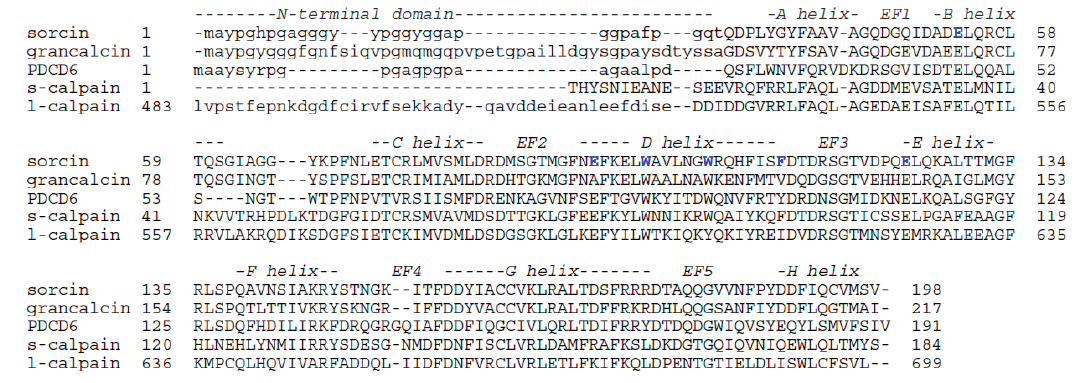
Figure 1. Sequence alignment of human PEF proteins of known crystal structures. Sorcin M-calpain chains are shown. The residues in the N-terminal domain are indicated as lowercase; the residues of the C-terminal calcium binding domain are indicated as uppercase. Structural alignment of EF-hands and of alpha-helices is reported.